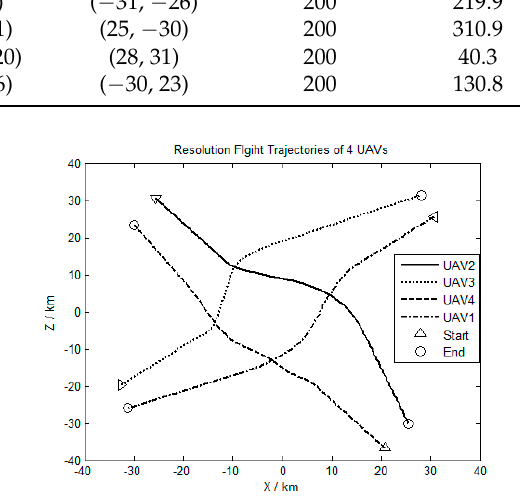
Figure 12. Resolution flight trajectories of 4 UAVs.